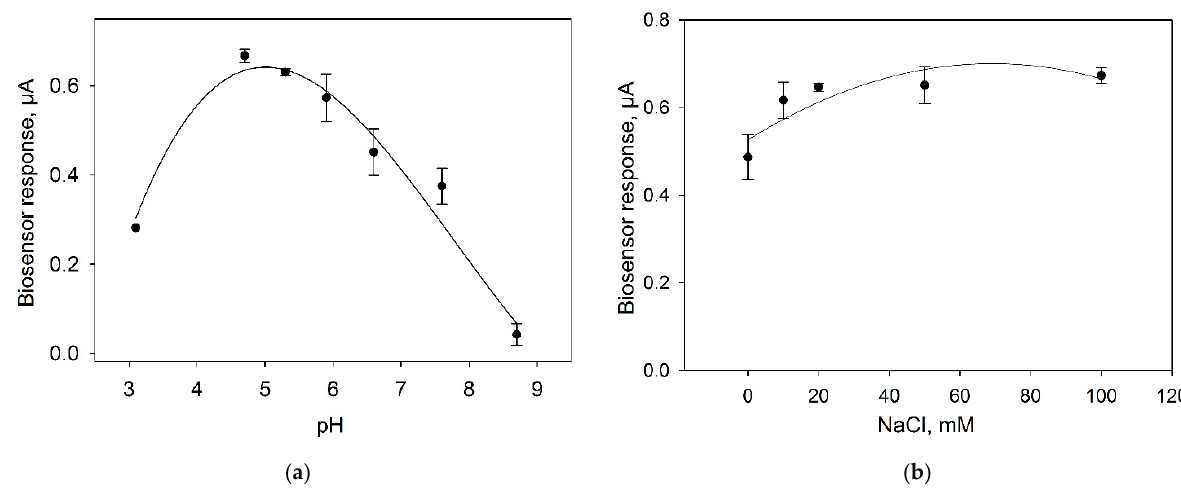
Figure 7. Effect of pH ( a ) and NaCl concentration ( b ) on the response of microbial biosensor. Concentration of glucose in